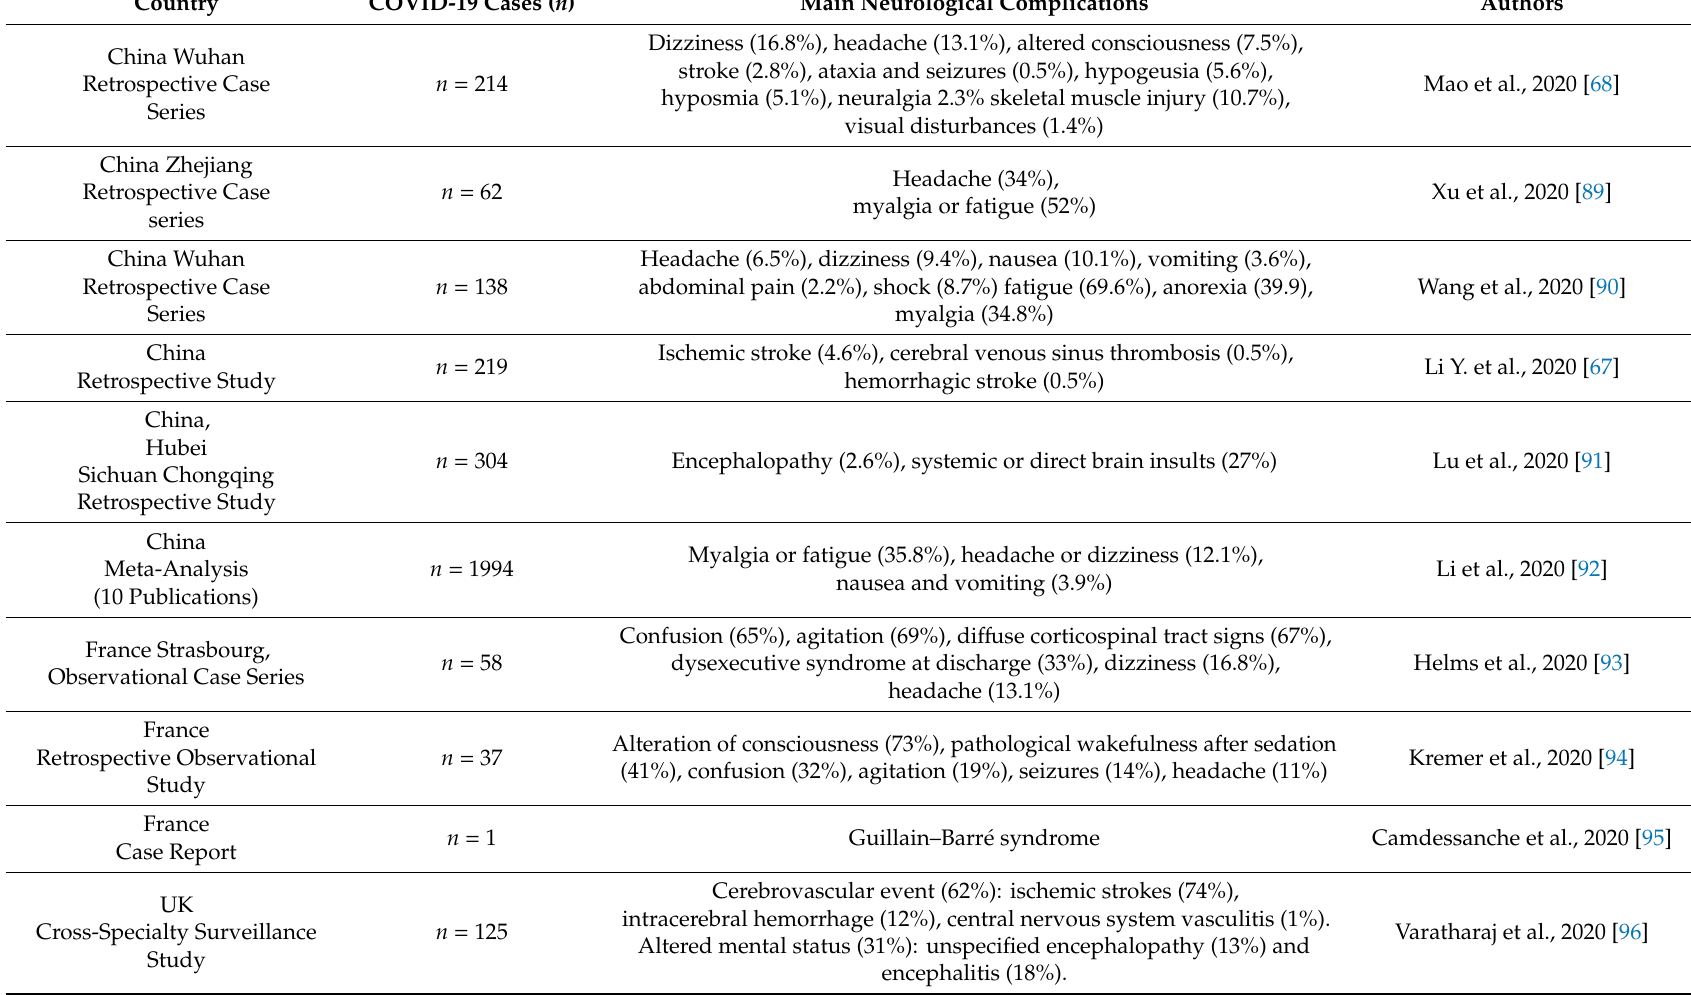
Table 1. Clinical experience with COVID-19 in di ff erent